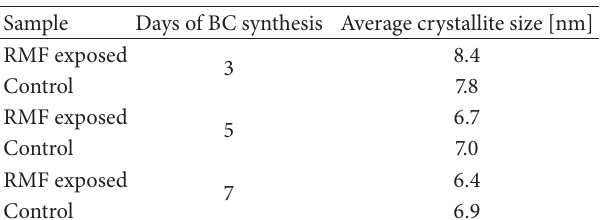
Table 2: Average crystallite size of control and RMF exposed BC samples.